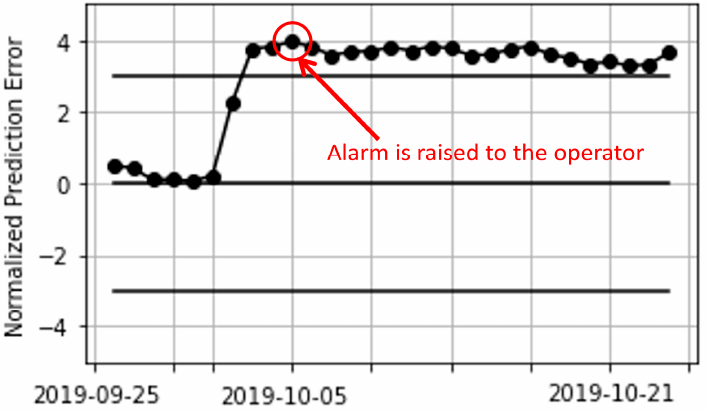
Figure 4. Calculated prediction error for an inverter fan malfunction for the NBM model. The algorithm sends daily alarms to the operator until the problem is corrected and the error returns to the acceptable